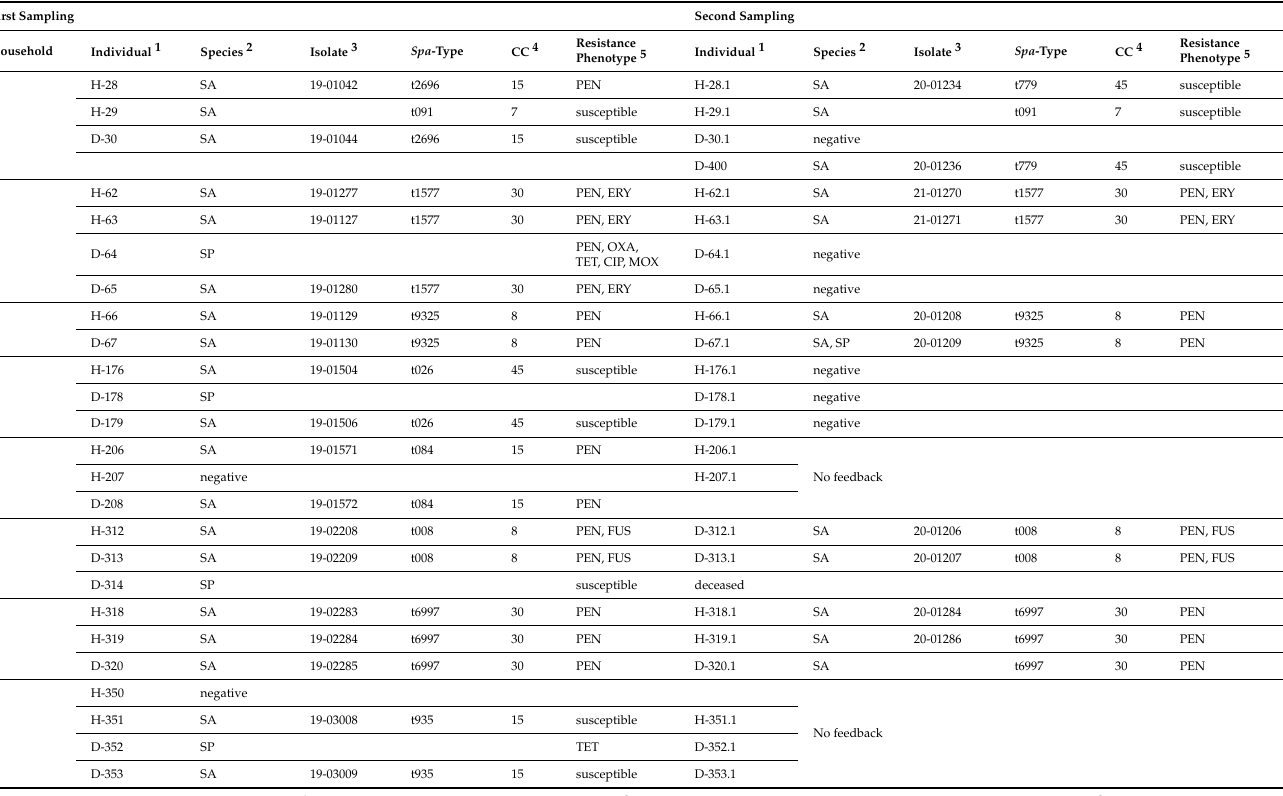
Table 3. Demonstration of S. aureus in humans und dogs living in the same